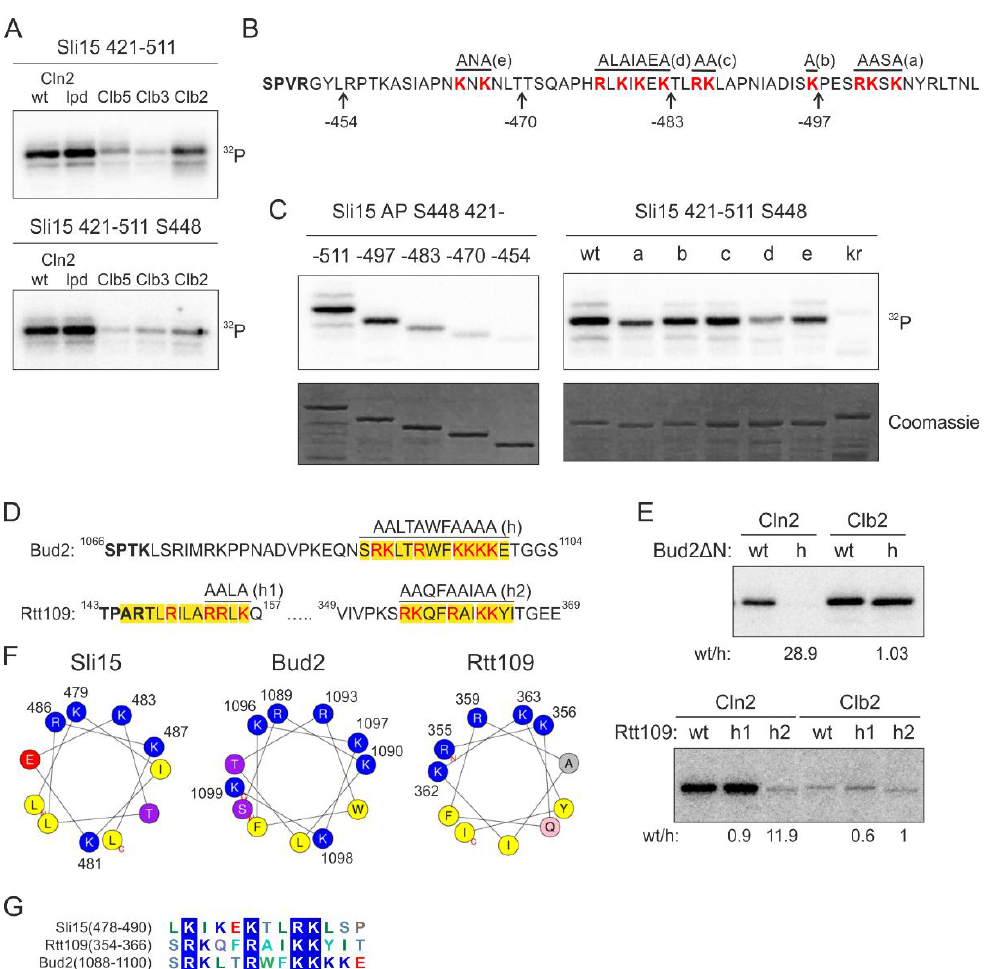
Figure 2. Clusters of basic residues promote phosphorylation by G1-Cdk1. ( A ) 32 P-autoradiographs of phosphorylation reactions of Sli15 fragment 421–511 with all phosphorylation sites (upper panel) or with just S448 as the only Cdk1 consensus site by different cyclin-Cdk1 complexes in vitro. ( B ) Sequence of Sli15 positions 448–511 showing the truncations and mutations used in panel C. ( C ) Phospho-images showing phosphorylation of the Sli15 mutants by Cln2-Cdk1. The mutants are described in ‘B’. In the kr mutant, all highlighted K/R residues are mutated to N/Q residues, respectively. ( D ) Sequences of the predicted α -helical K/R docking motifs in Bud2 and Rtt109. ( E ) 32 P-autoradiographs showing the phosphorylation of Bud2 and Rtt109 proteins by Cln2- and Clb2-Cdk1. wt/h shows the relative phosphorylation rate of the wild-type substrate protein compared to the K/R docking site mutant. ( F ) Helical wheel representations of the K/R docking motifs in Sli15, Bud2 and Rtt109 show the clustering of basic residues on one side of the α -helix. ( G ) Multiple sequence alignment of K/R motifs in Sli15, Bud2 and Rtt109.